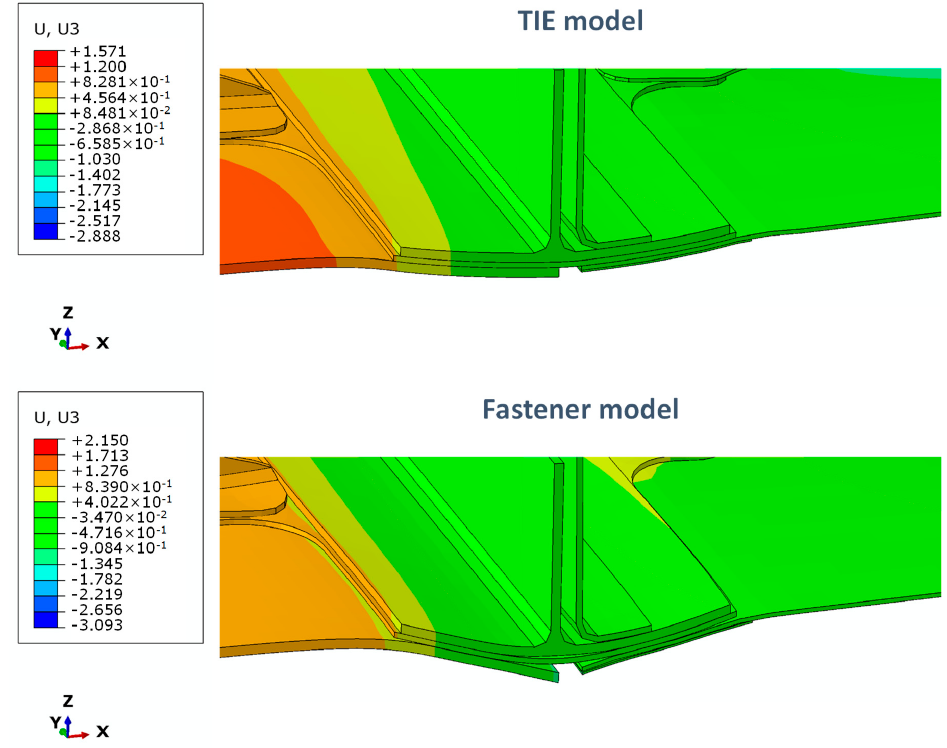
Figure 20. Out of plane displacements at 300 kN (10 × deformation factor in the z-direction–units in mm).